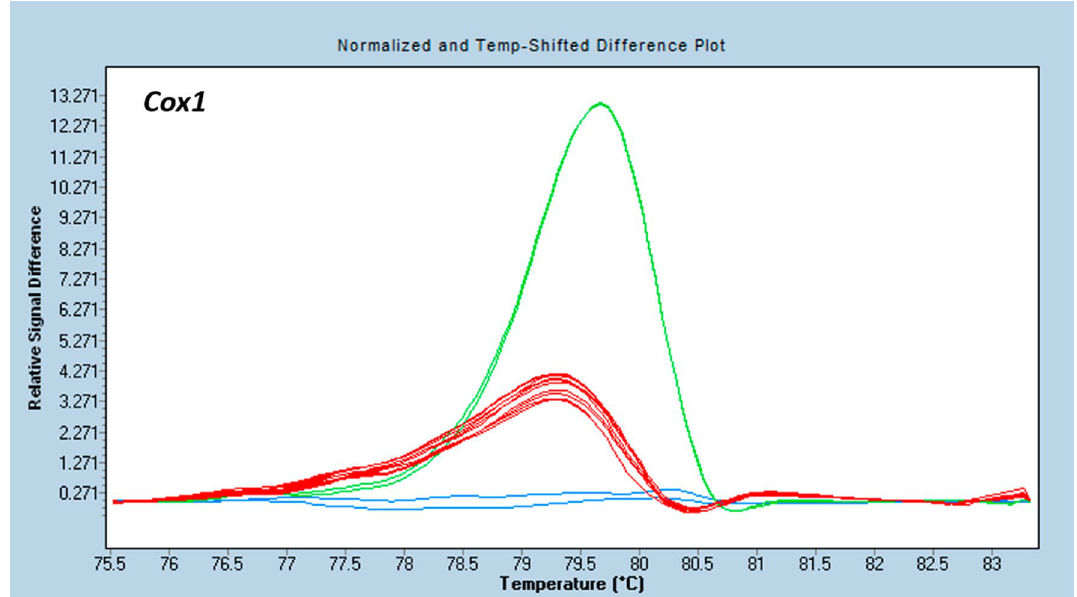
Figure 2. Discrimination between the plasmotypes of the different genera used during fusion experiments with the HRM marker Cox1 . Distinct coloured curves are significantly different as calculated by the Gene Scanning software (Roche Diagnostics). Melting profiles differed between carrot ‘Dolanka’ (green), carrot ‘Parmex’ (red) and celeriac ‘Diamant’ (blue).